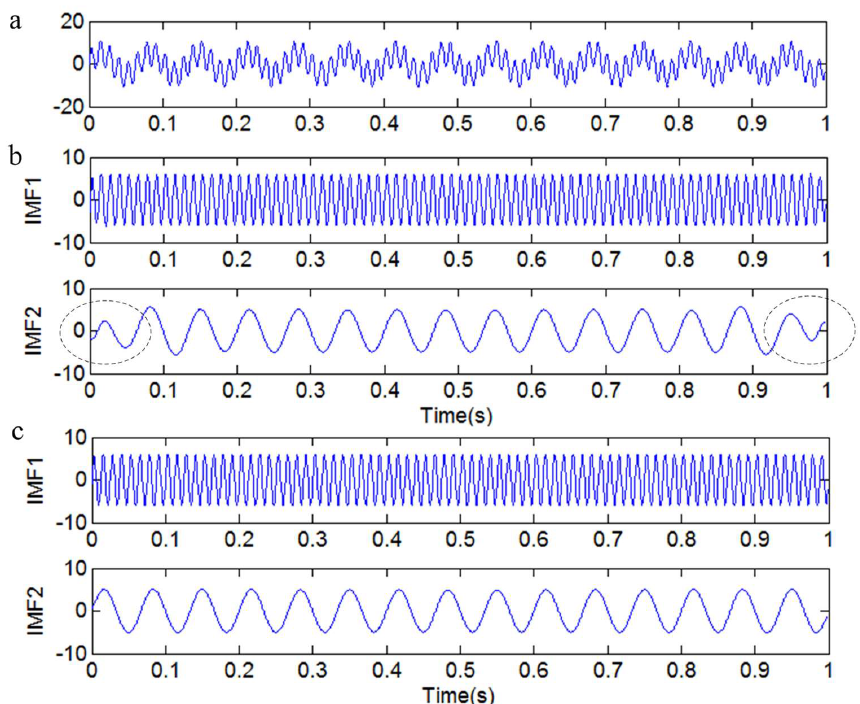
Figure 3. The simulated signal y 1 ( t ) and intrinsic mode functions (IMFs). ( a ) The simulated signal y 1 ( t ); ( b ) the IMFs obtained by the original empirical mode decomposition (EMD) method; ( c ) the IMFs obtained by the local linear extrapolation method.